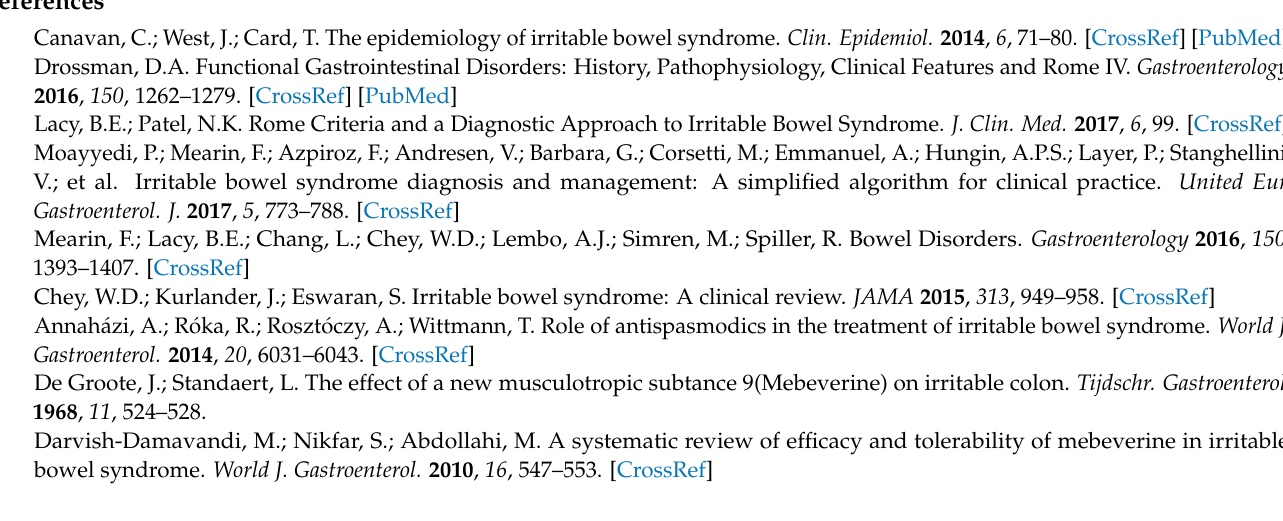
and depression, Table S12: Summary of the safety results, Table S13: Comparison of various IBS diagnostic criteria, Table S14: Prevalence of IBS in patients diagnosed by different